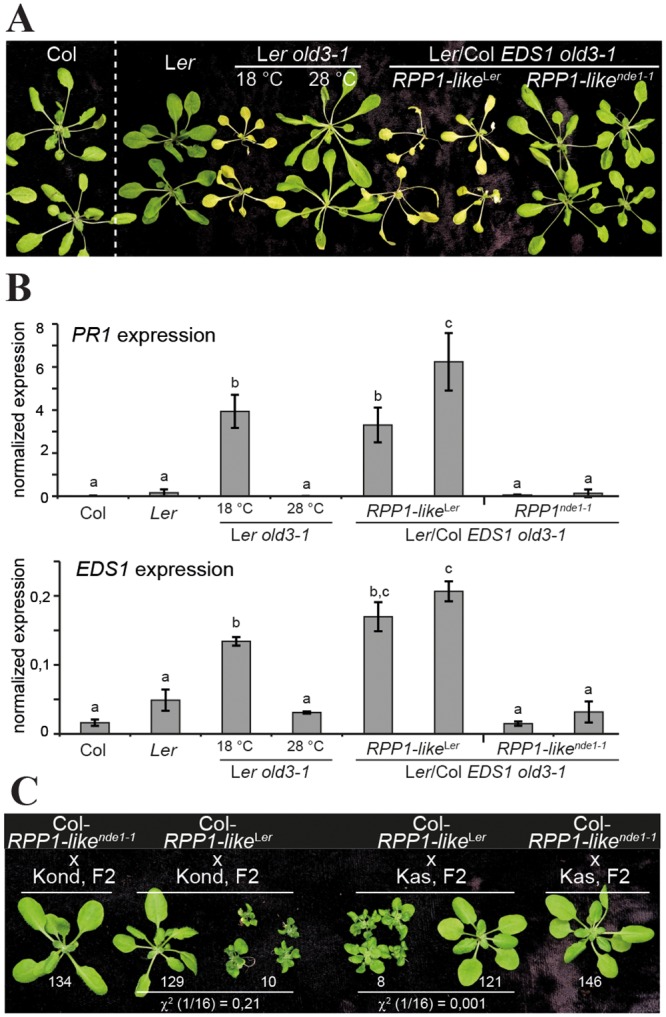
Contribution of RPP1-likeLer
DM2h to autoimmunity.A. Suppression of old3-1-induced autonecrosis by nde1-1. Col/Ler hybrids homozygous for old3-1 and either RPP1-likeLer or RPP1-likende1-1 and control plants were grown at 28°C for three weeks. Plants were then shifted to 18°C or not (Ler old3-1 28°C), and phenotypes recorded at 8 d pts. F3 families originating from crosses of old3-1 with two independent Col-RPP1-likeLer or Col-RPP1-likende1-1 NILs were tested with similar results. Growth of Col plants was documented in the same experiment under the same conditions, but not in the same image, and is therefore separated by a dashed white line. B. PR1 and EDS1 gene expression in the lines shown in (A). RNA was extracted from the same plants at 24 h pts and cDNA used for transcript analysis by qRT-PCR. Gene expression was normalized to UBQ10. Standard deviation of three biological replicates is shown. Letters indicate statistically significant differences (ANOVA, Tukey’s Post-hoc test, p < 0,01). C. Suppression of SRF3Kas/Kond-induced hybrid necrosis by nde1-1. Col NILs containing either RPP1-likeLer or RPP1-likende1-1 were crossed to Kas and Kond, and occurrence of incompatible hybrids was recorded in 5-week-old F2 plants grown at 14°C (the restrictive temperature for Ler x Kas-2/Kond HI [27]. Numbers of wild type-like or necrotic plants observed in different F2 populations are indicated. Chi2 values for the segregation hypothesis of 1/16 necrotic/wild-type plants are indicated for segregating F2s.